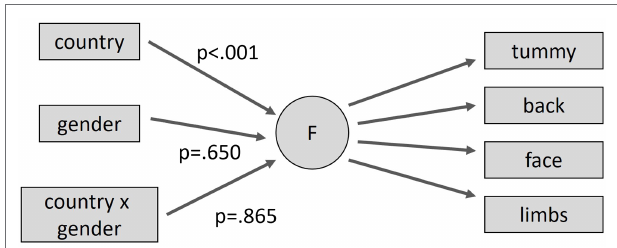
FIGURE 3 | Testing structural differences in maternal stroking behavior by country and gender (males and United Kingdom taken as reference category for dummy